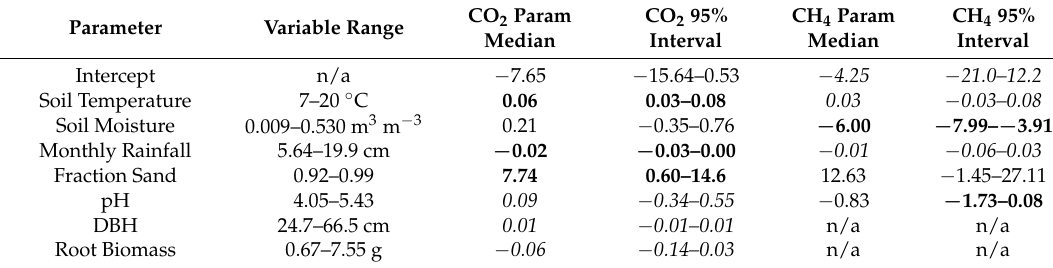
Table 1. Fixed regression parameters were estimated separately for CO 2 flux and CH 4 uptake Bayesian linear mixed models. Bolded regression parameters reflect posterior estimates with more than 90% of the posterior probability density different from zero, and italicized parameter estimates reflect posterior distributions where >50% of the probability density bridges zero. DBH: diameter at breast height (1.3 m from ground